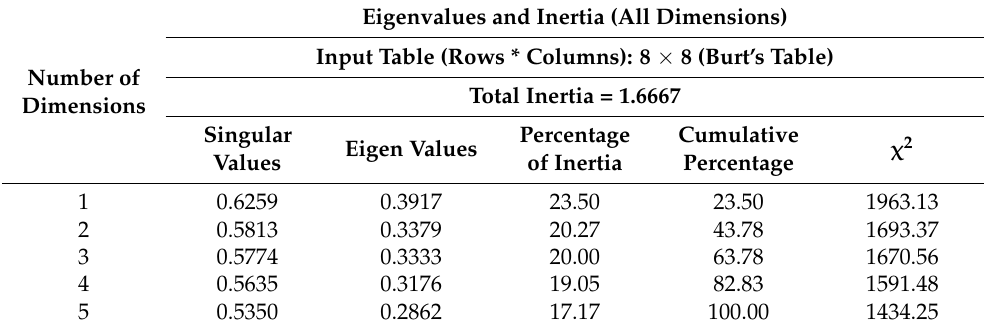
Table 7. Eigenvalues and inertia for all dimensions relating to country, period of use of the largest amount of tap water supplied and the use of an additional tap water filtration and/or treatment device. Eigenvalues and Inertia (All Dimensions) Input Table (Rows * Columns): 8 × 8 (Burt’s Table) Number of Total Inertia = Dimensions